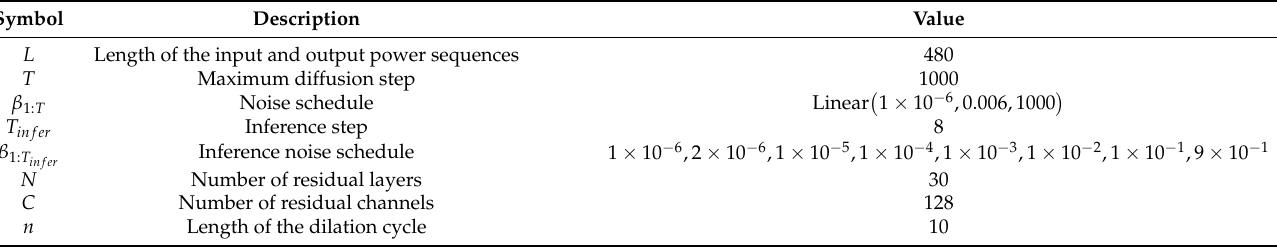
Table 2. Hyperparameters of the